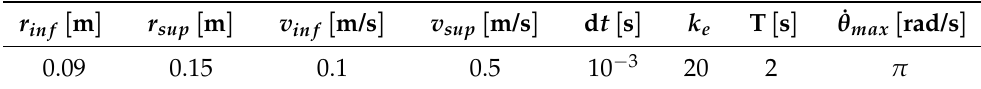
Table 2. Parameters values used for